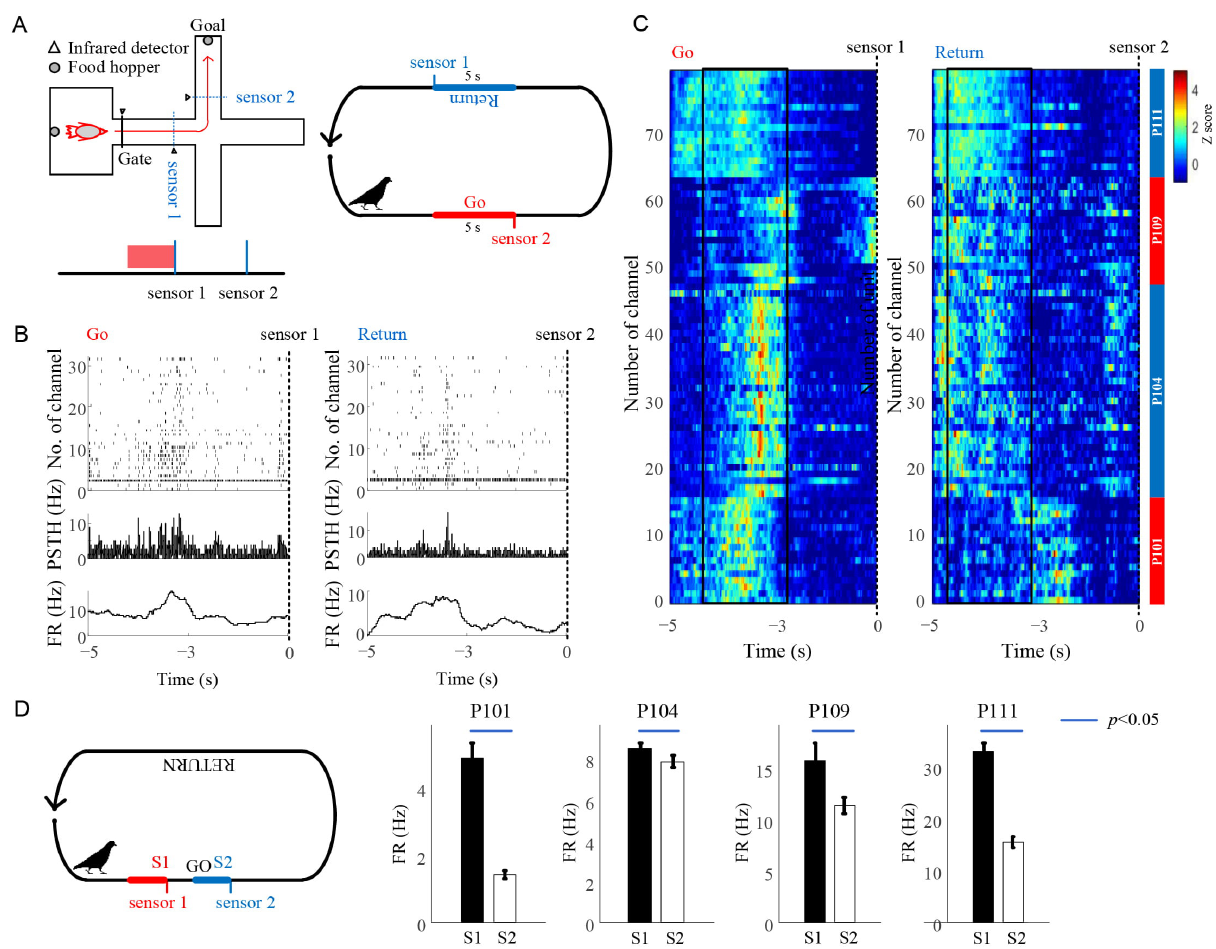
Fig. 5. NCL neural activities in the fixed-goal task. (A) Diagram of the task (top) and the location of decision-making (bottom), and diagram of the event window (right) for (B) and (C). (B) Examples of neural activities at the intersection in a trial are highlighted in (A). Dashed lines indicate the location of the sensor. From top to bottom: raster plots, PSTH, FR curve obtained by averaging the dot raster and smoothing with a 0.1 s boxcar window. (C) The average, Z-scored activity of single task-modulated channels across all trials ( n = 80). Dashed lines indicate the location of the sensor. Colors depict instantaneous neuronal firing rates (0.1-s bins), averaged across all animal trails. (D) Comparison of the firing rate between the S1 and S2 windows. S1 is expressed as 2.5 s before sensor 1, and S2 is defined as 2.5 s before sensor 2, as shown in the left sub-figure. Error bars indicate